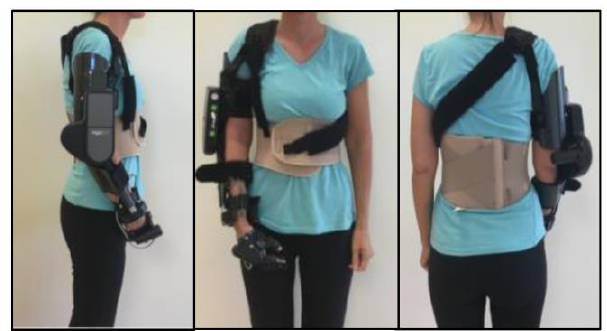
Figure 1: Externally-powered technology for individual with bilateral brachial plexus